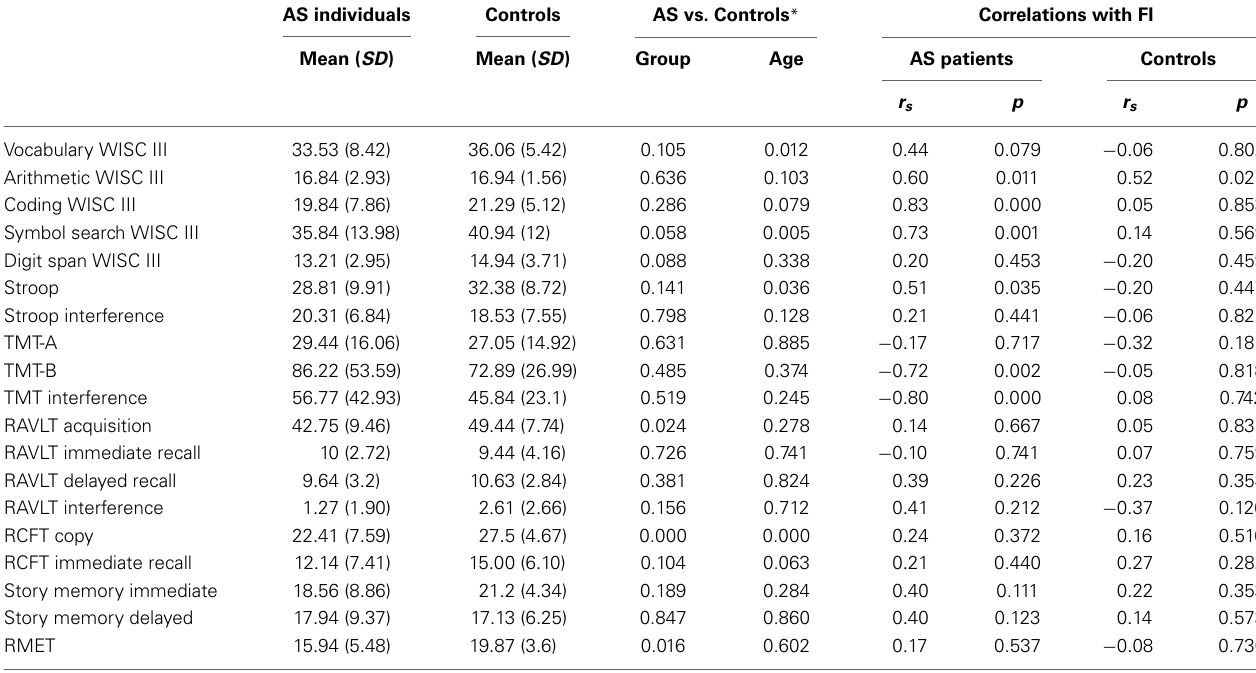
Table 2 | Mean, SDs, and group differences between AS and controls. AS individuals Controls AS vs. Controls * Correlations with FI Group Age AS patients